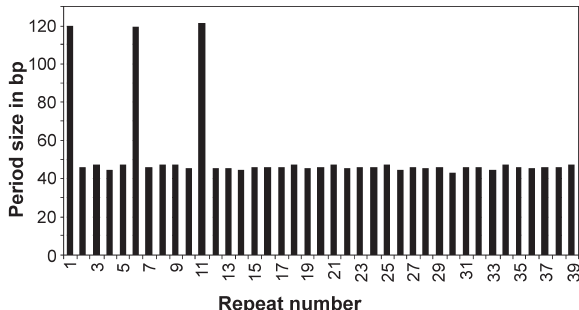
Figure 1. Periodic distribution of the GTAAGAAAGGGAGGCTCC TGAAAATGGAGA repeat in A. fulgidus (gi ⎮ 2689296 section 134 of 172 of the complete genome; only specific repeats on the plus strand were considered). This repeat was found to be specific to A. fulgidus by BLAST searches against the entire GenBank nucleotide database .